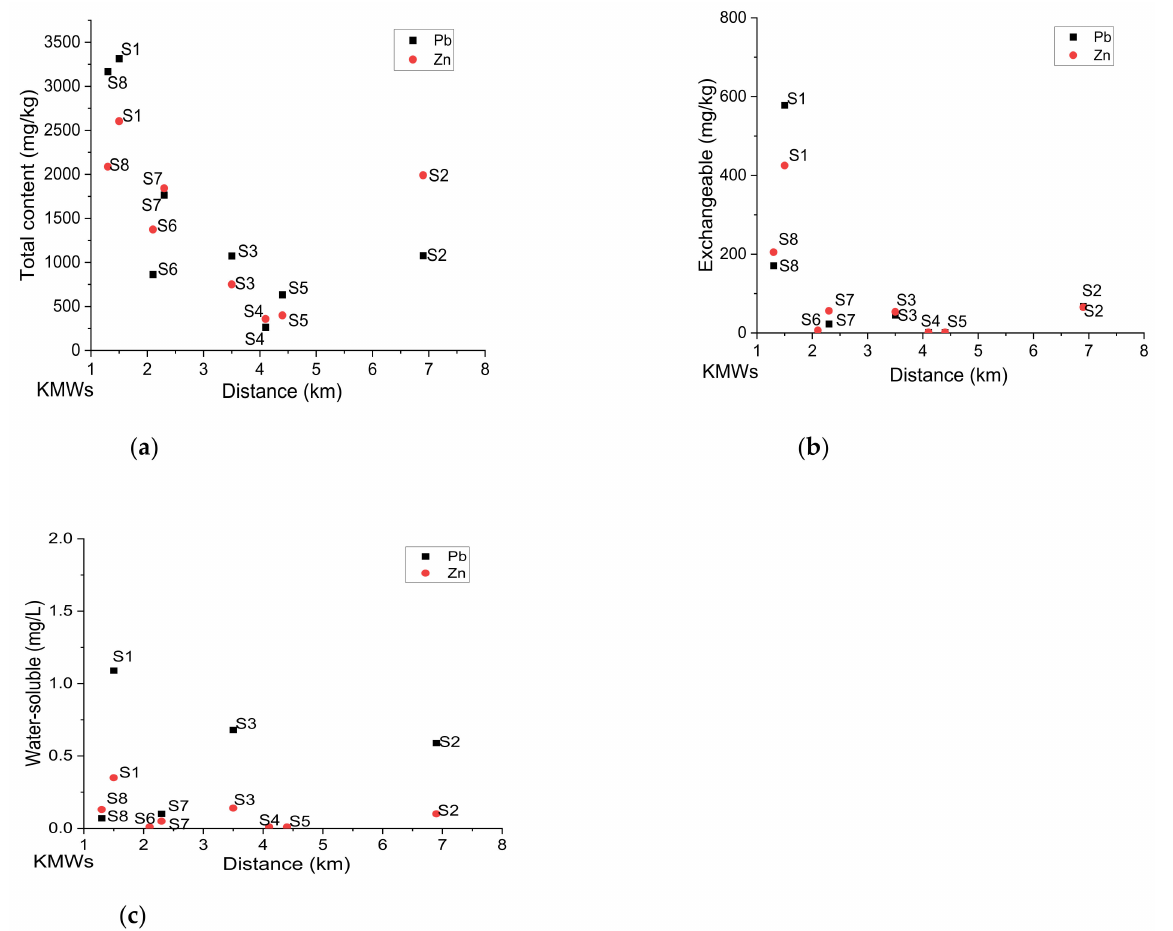
Figure 5. The distribution of Pb and Zn with the distance of each playground from Kabwe Mine Wastes (KMWs): ( a ) contents (XRF), ( b ) exchangeable and ( c )